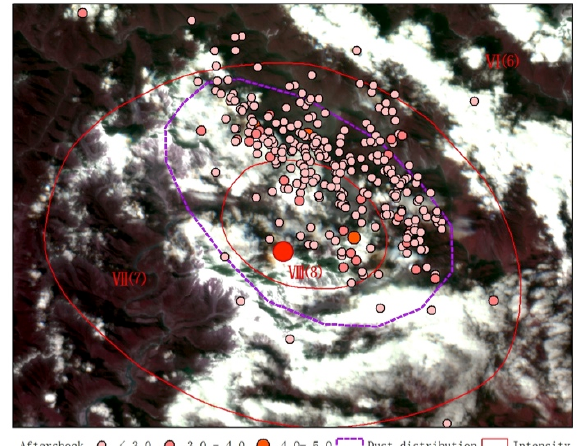
Figure 4. The dust distribution detected from GF-4